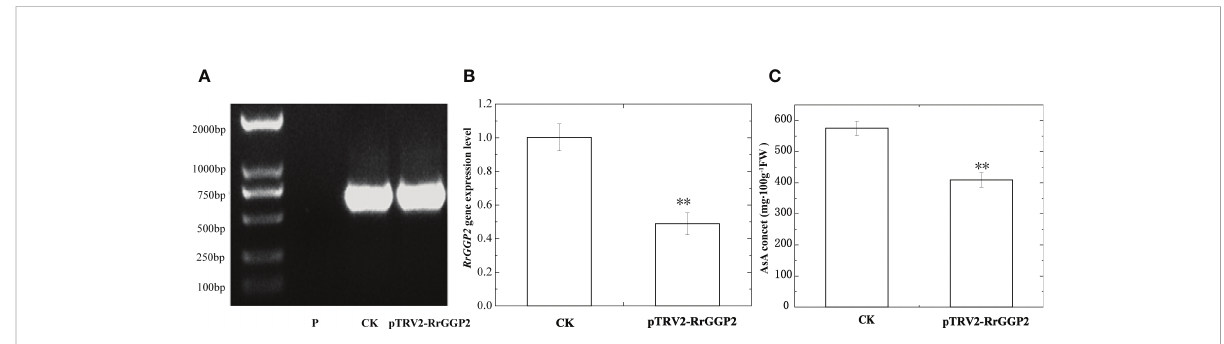
FIGURE 5 Silencing of RrGGP2 gene in R. roxburghii fruits. Detection of TRV2 transcripts (A) , RrGGP2 expression levels (B) and AsA content (C) after VIGS. P, untreated; CK, treated with TRV2 ; pTRV2-RrGGP2 , treated with pTRV2- RrGGP2 . ** Represents P < 0.01 compared with CK.